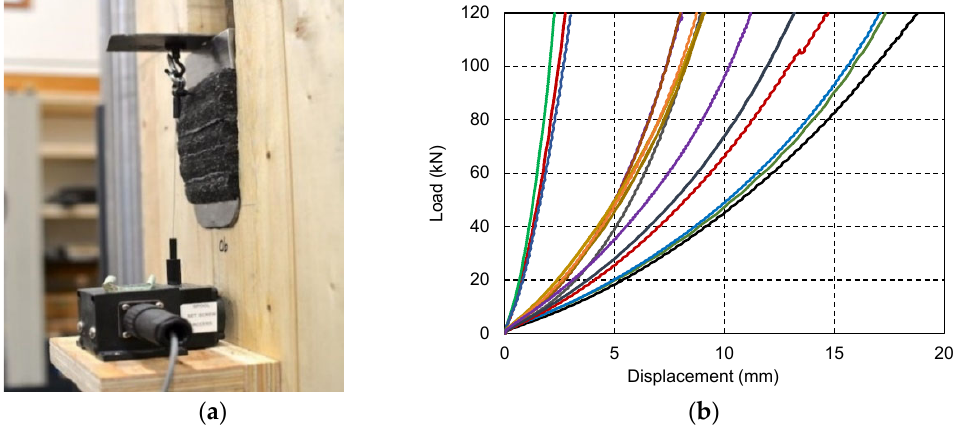
Figure 13. ( a ) Deformed HD (photo credit: Thomas Tannert); ( b ) force–displacement curves.